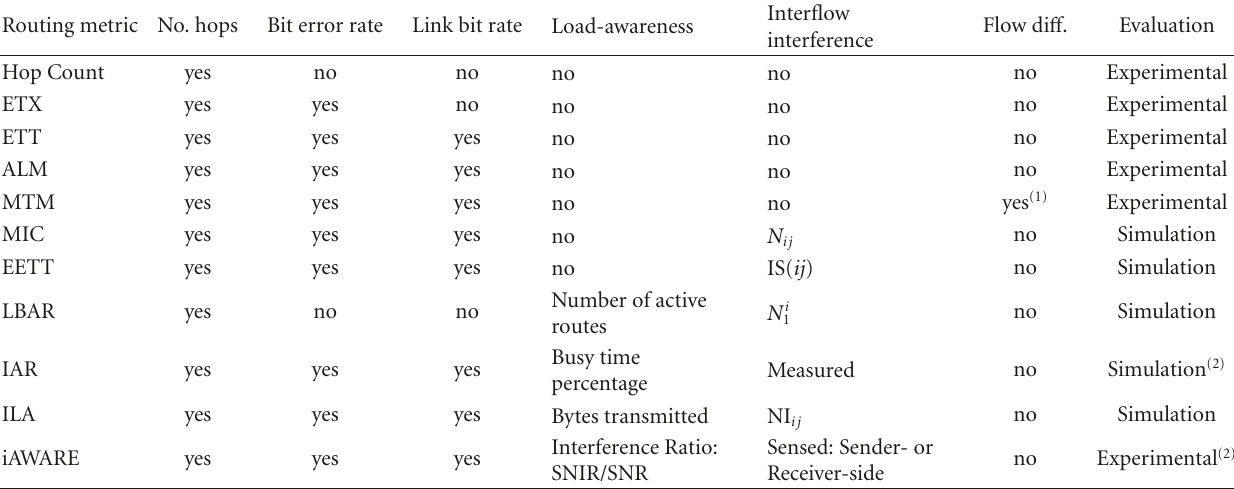
Table 2: Comparison of routing